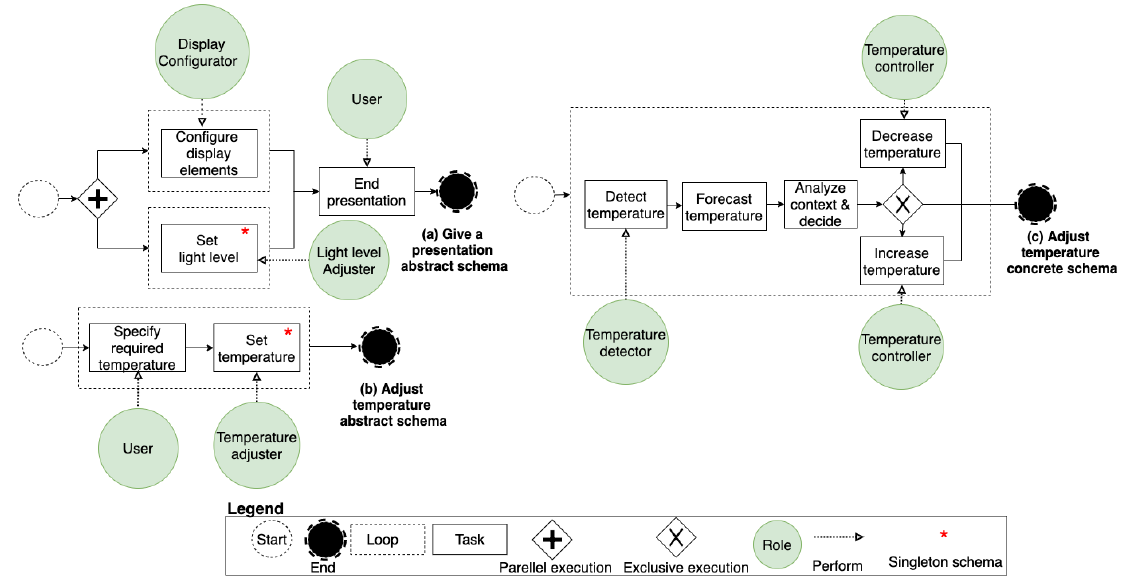
Figure 6. A representation of an abstract and concrete schemas in the smart building